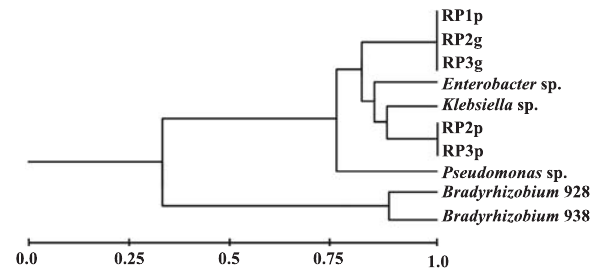
Figure 1. Dendrogram based on UPGMA cluster analysis with the NTSYS-PC program using rep- PCR and nifH -PCR-RFLP data obtained from L. albescens isolates (RP1p, RP2g, RP3g, RP2p, and RP3p) and strains used as control ( Bradyrhizobium sp. SEMIA 928, Bradyrhizobium sp. SEMIA 938, Enterobacter sp., Pseudomonas sp., and Klebsiella